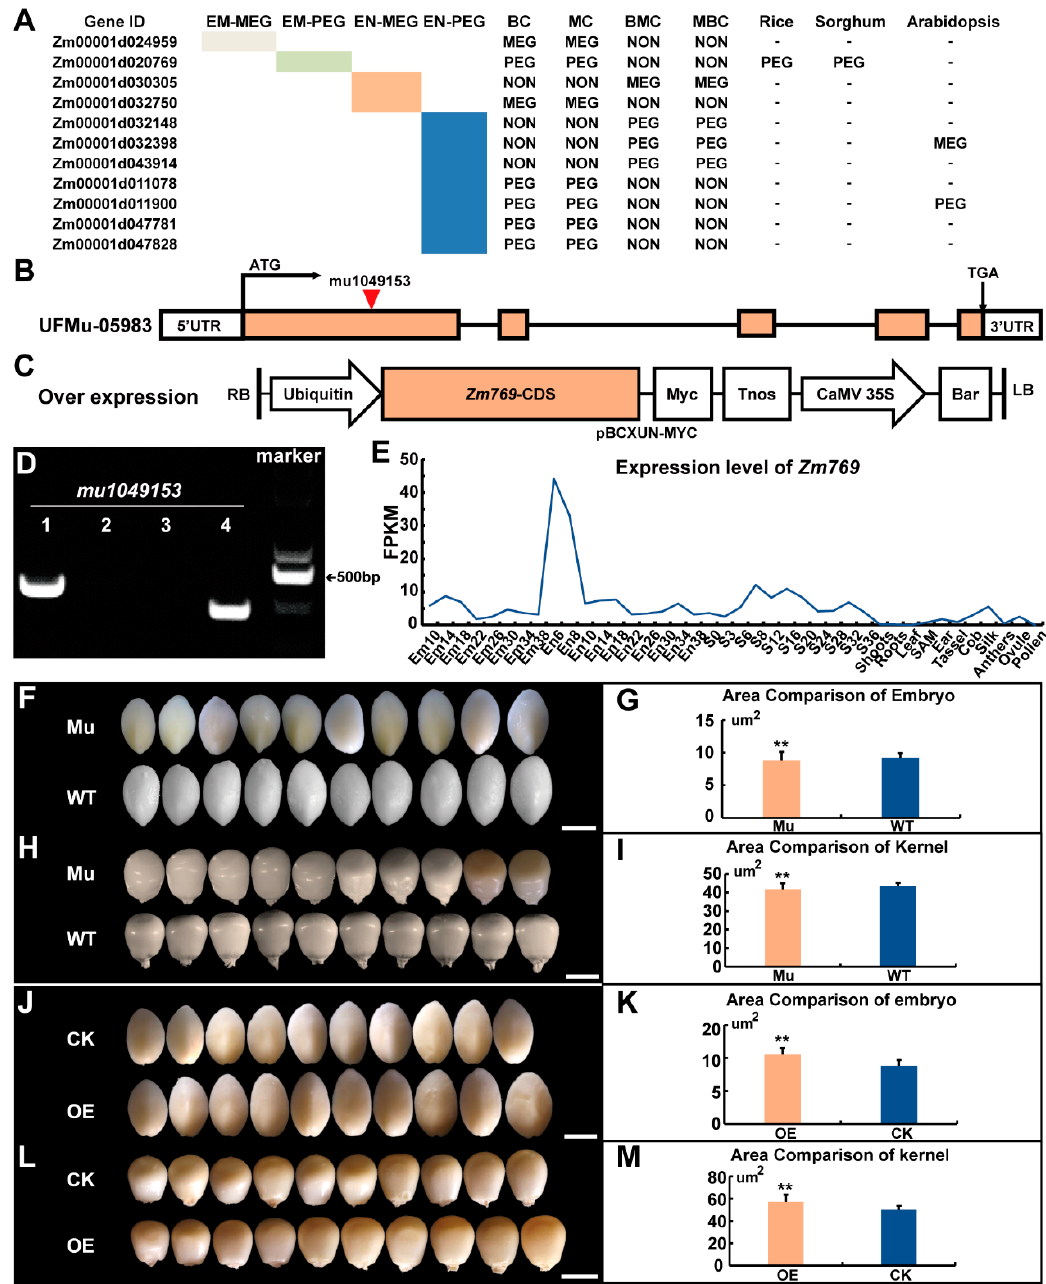
Figure 4. Embryo and kernel phenotypes of the Zm769 mutant and overexpression lines. ( A ) Con ‐ servation of non ‐ conserved imprinted genes across species. ( B ) Locus of mu1049153 insertion in UFMu ‐ 05983. ( C ) Carrier structure of overexpression lines of Zm769 . ( D ) Verification of Mu inser ‐ tion of the Zm769 gene: mu1049153. Lanes 1 and 3 represent the wild ‐ type (W22) DNA; lanes 2 and 4 represent the mutant DNA. Lanes 1 and 2 represent samples using the forward and reverse pri ‐ mers from the corresponding gene sequence (Supplemental Table S6); Lanes 3 and 4 represent sam ‐ ples using TIR6 as the forward primer and the same reverse primers as Lanes 1 and 2 (Supplemental Table S6). ( E ) Expression level of Zm769 . ( F , G ) Embryo phenotypes of the mutant line and back ‐ ground line. ( H , I ) Kernel phenotypes of the mutant line and background line. ( J , K ) Embryo pheno ‐ types of the overexpression line and transgene receptor line. ( L , M ) Kernel phenotypes of the over ‐ expression line and transgene receptor line. Significant differences were analyzed by two ‐ tailed Stu ‐ dent’s t tests (** p < 0.01).